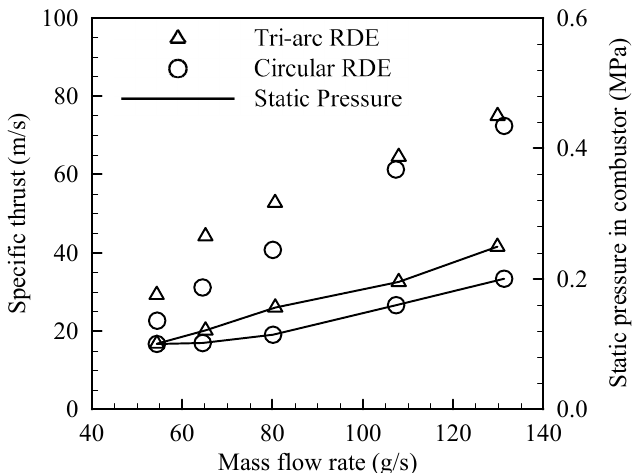
Figure 16. Specific thrust and static pressure of the tri-arc and circular RDEs.